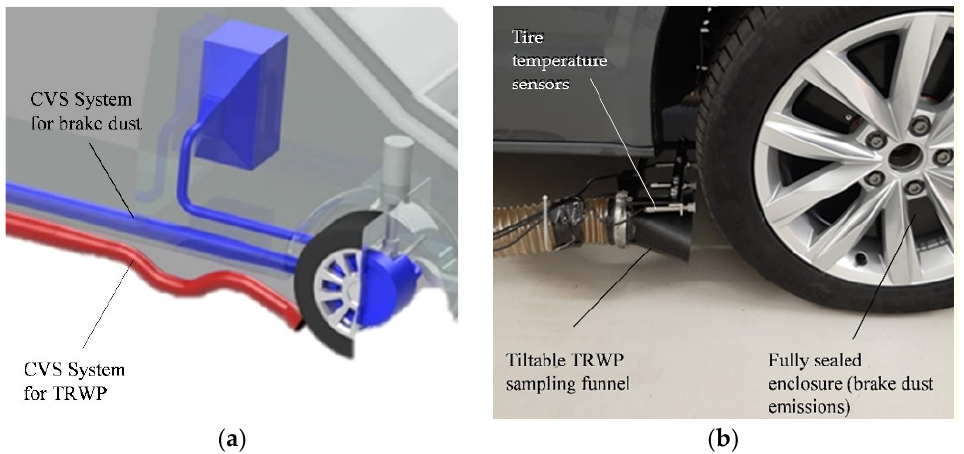
Figure 1. ( a ) Assembled sampling system on vehicle with brake enclosure; ( b ) implemented tyre sampling system with inlet funnel and temperature sensors.